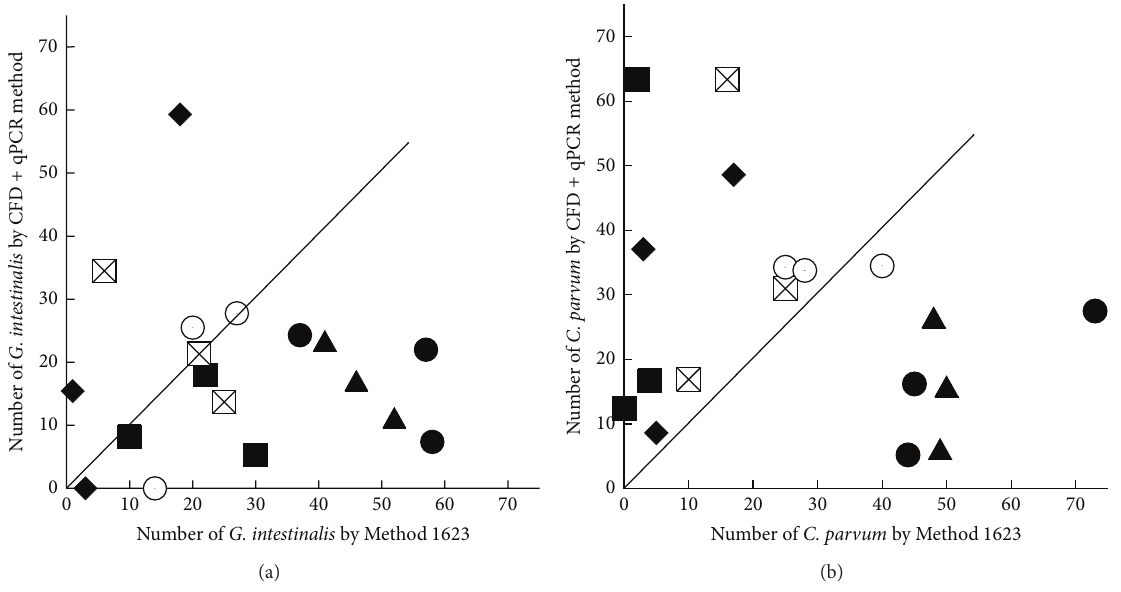
Figure 2: A comparison of split sample analysis at various turbidity amounts by Method 1623 and the CFD + qPCR method for Giardia intestinalis (a) and Cryptosporidium parvum (b). The solid lines represent a 1: 1 correspondence of results. Solid circles: tap water 0.2NTU, open circles: tap water 0.4 NTUs, x-squares: 1.1 to 1.3 NTUs, triangles: 3.8 NTUs, squares: 7.1NTUs, and diamonds: 54 NTUs.